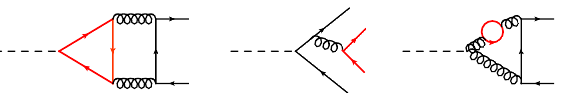
Figure 6. Differential predictions for the ( m H -scaled) energy of the leading jet, in 2-jet events defined with y cut = 0 . 1 . Results are presented for a variety of different requirements on the final state jets, either requiring exactly two jets H → jj (blue) or exactly two b -tagged jets (red). The lower panels present the impact of the mixed EFT- y b piece at O ( α 2 ) , O ( α 3 ) , and the combined s s EFT- y b and EFT 2 piece at O ( α 3 ) , with respect to the NLO y 2 s b